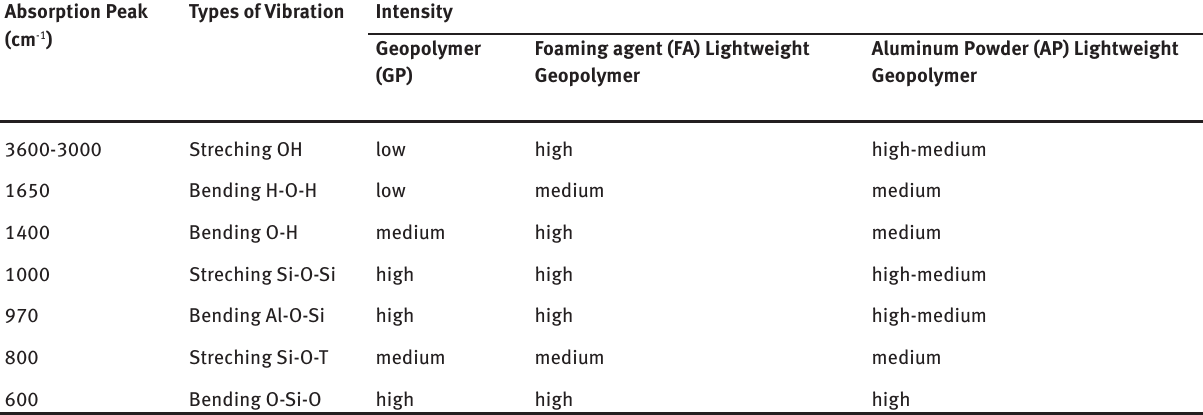
Table 3: Functional groups detected on lightweight geopolymer synthesized without and with pore-forming agent. Absorption Peak (cm -1